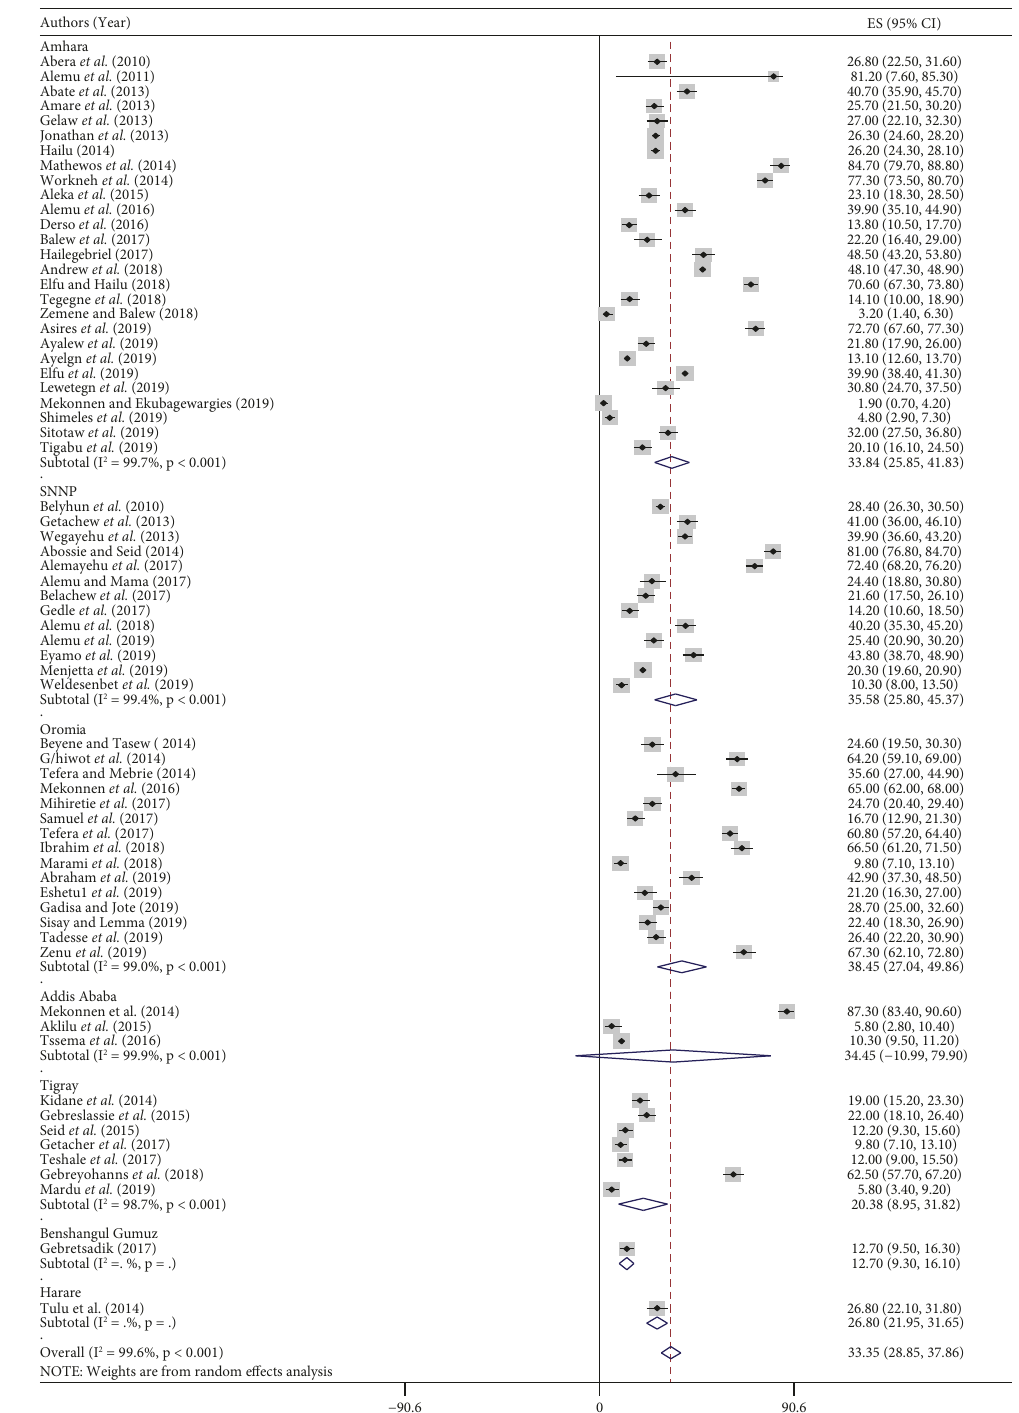
Figure 2: Forest plot showing the overall pooled prevalence of intestinal helminths in Ethiopia including the region